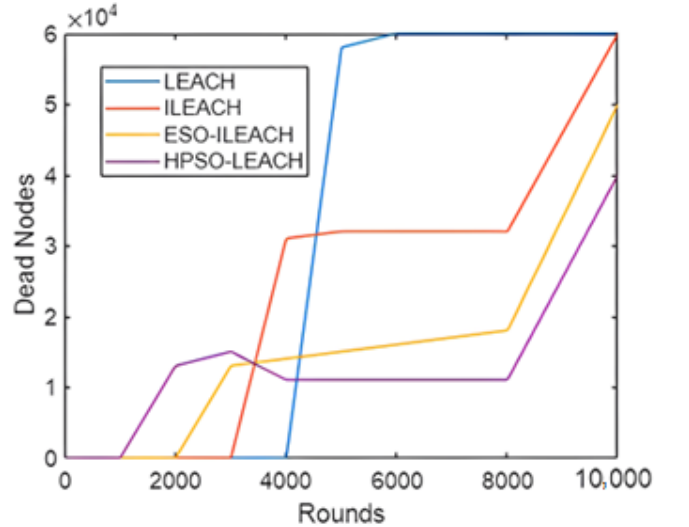
Figure 9. Alive nodes.